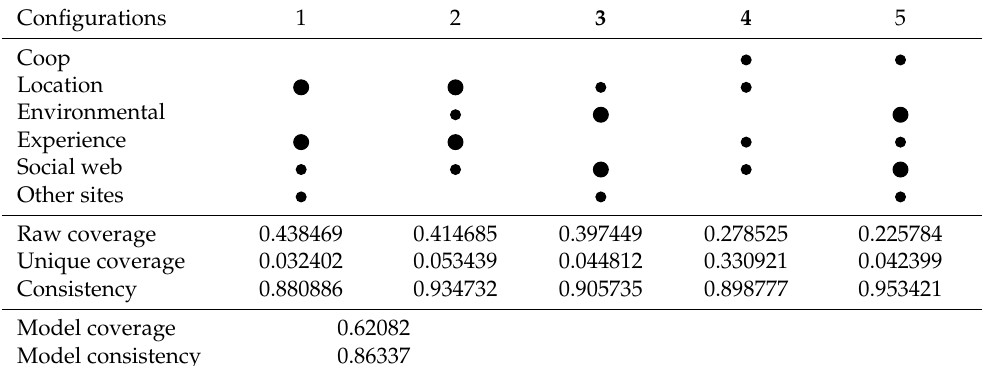
Table 3. fsQCA analysis